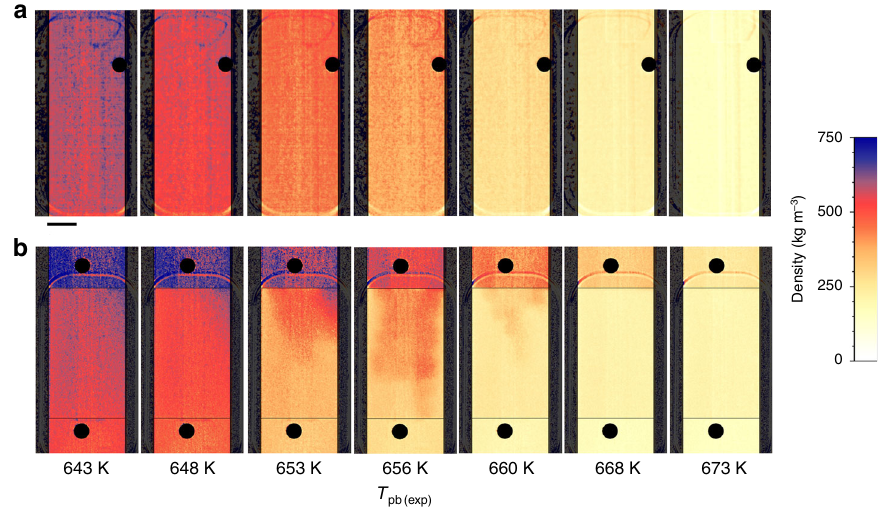
Fig. 7 Comparison between monolith-free and monolith cases. It shows a set of color scaled density images at different temperatures recorded during isobaric heating at 250 bar in experiments without a and with b the monolith; it is evident that the density fi eld is homogenous without monolith; the co- existence of LL and GL supercritical water is visible only in the presence of the monolith; the length of the scale bar is 5